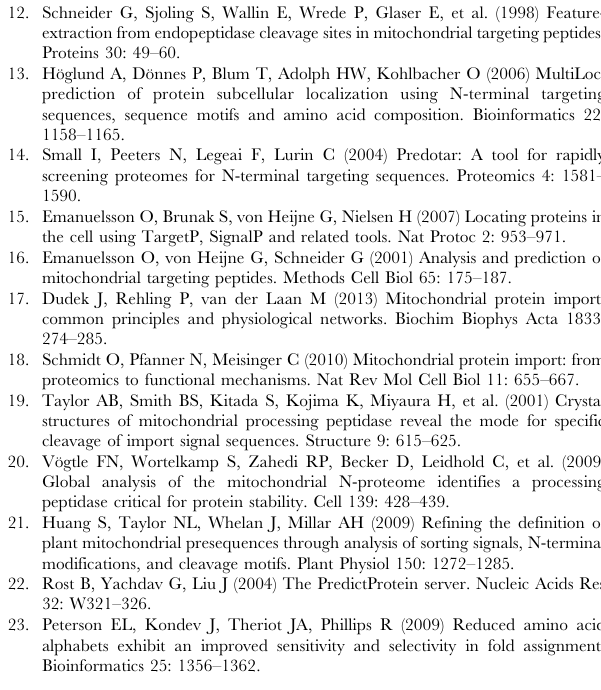
Figure S2 N-terminal secondary structure analysis of all mature sequences (excluding H. sapiens ) associated the five shortest and five longest MTSs. See Figure 4 for description. Table S1 Quantitative comparison of sequence charac- teristics and amino acid groupings of MTS and mature protein sequences for each species used in this investi- gation. Dataset S1 Mitochondrial matrix protein dataset. A complete list of mitochondrial matrix proteins, gene IDs, accession numbers and both MTS and mature sequences used in this